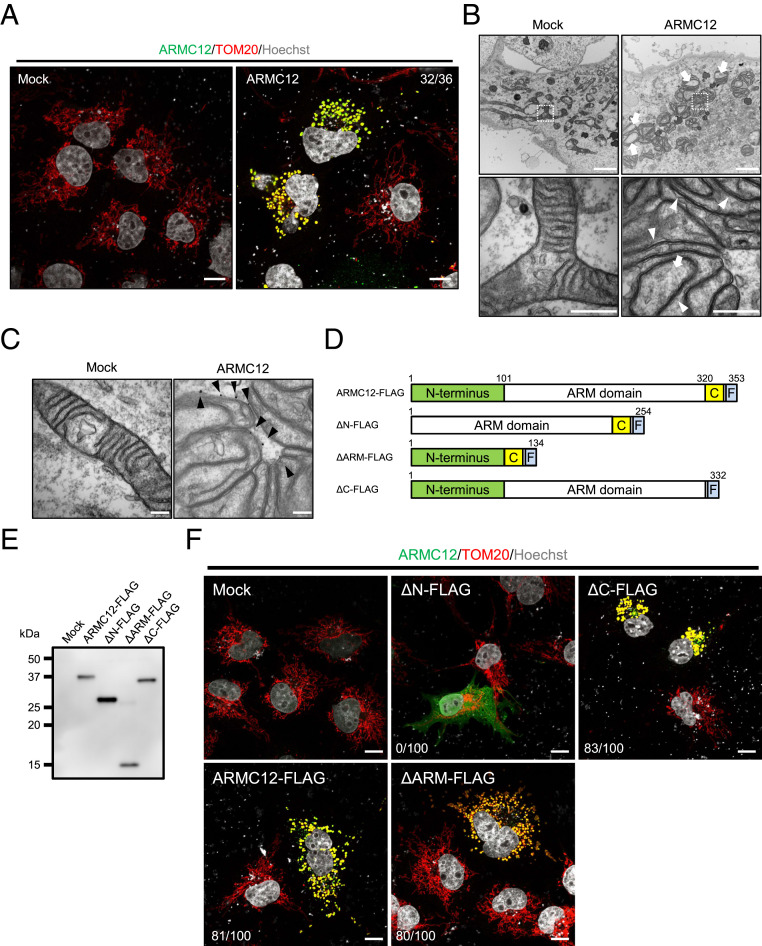
ARMC12 functions as an adherence factor between mitochondria in cultured cells. (A) COS-7 cells transiently expressing FLAG-tagged ARMC12 protein were stained with FLAG (green) and TOM20 (red) to visualize ARMC12 and mitochondria, respectively. Hoechst 33342 (white) was used to visualize the nuclei. (Scale bars, 10 µm.) The numbers in the upper right corner indicate the number of cells with mitochondrial aggregation out of the number of cells with FLAG fluorescence. (B) TEM micrographs of COS-7 cells overexpressing a control vector (Left) or ARMC12 protein (Right). (Lower) Magnified images of the boxed areas. Arrows indicate mitochondria with reduced cristae. Arrowheads indicate the border between mitochondria. (Scale bars, 2.0 μm and 500 nm, respectively.) (C) Immunolabeled detection of transiently expressing FLAG-tagged ARMC12 in COS-7 cells was observed by TEM using anti-FLAG antibody combined with 1.4 nm gold-particle–conjugated secondary antibody (arrowheads). (Scale bars, 200 nm.) (D) Schematic of various truncated ARMC12 vectors. FLAG-tag was linked posterior to the C-terminal of ARMC12. Green and yellow boxes show the N terminus and C terminus of ARMC12, respectively. Light blue boxes indicate FLAG tag. A five-amino-acid spacer is inserted between the C terminus and FLAG tag. (E) HEK293T cells were transfected with plasmids encoding FLAG-tagged full length ARMC12 and truncated forms of ARMC12. Cell lysates were analyzed by immunoblotting using an anti-FLAG antibody. (F) COS-7 cells transiently expressing truncated ARMC12 were stained with FLAG (green) and TOM20 (red) to visualize ARMC12 and mitochondria, respectively. Hoechst 33342 (white) was used to visualize the nuclei. (Scale bars, 10 µm.) The numbers in the lower left corner indicate the number of cells with mitochondrial aggregation out of the number of cells with FLAG fluorescence.